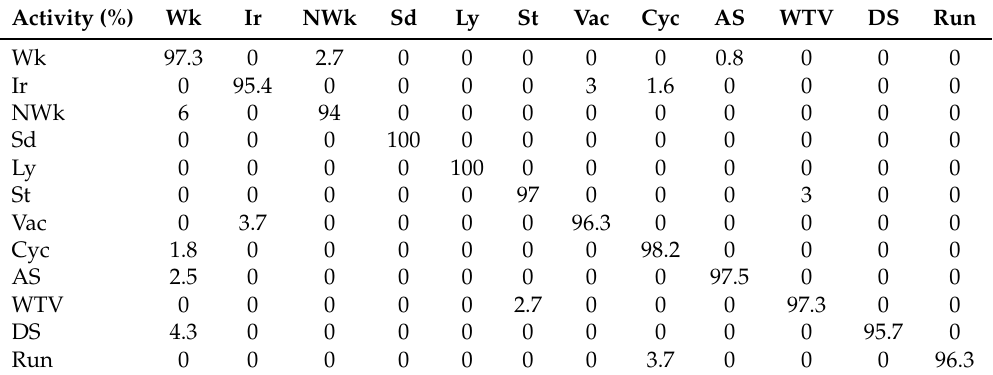
Table 3. Confusion matrix of the CNN-LSTM model.